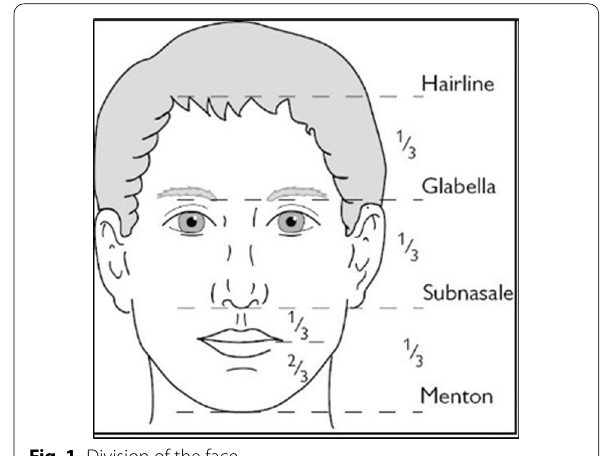
Fig. 1 Division of the face